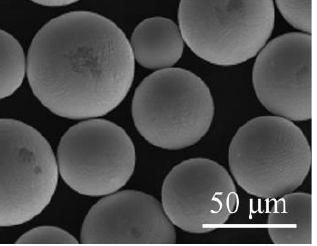
Figure 1. Scanning electron microscope picture of the CLF-1 powder produced using the PREP method.